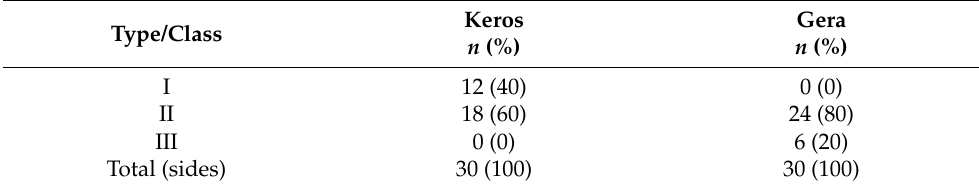
Figure 1. Keros and Gera classifications of the anterior skull base configuration. Keros compares the vertical height difference between the cribriform plate and the ethmoid roof. Gera is the calculation of the angulation between the horizontal plane of the cribriform plate floor and the lateral lamella. The smaller the angle, the higher the risk of inadvertent penetration. Table 2. Keros vs. Gera classification. Keros I—height difference of <4 mm between cribriform plate (CP) and ethmoid roof (ER). Keros II and III—4–8 mm and >8 mm height differences, respectively. Table 3. Comparison of sides of anterior skull base according to Keros and Gera Gera: class I (> 80 degrees, low risk), class II (45 to 80 degrees, medium risk), and class III (<45 de-